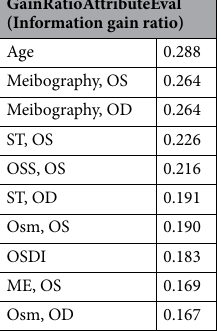
Table 7. Most important features predicting an unstable tear film in the left eye with information gain ratio. OD right eye, OS left eye, ST Schirmer test, ME meibomian gland expressibility, OSDI ocular surface disease index, OSS ocular surface staining, Osm osmolarity, Meibography degree of MG dropout.